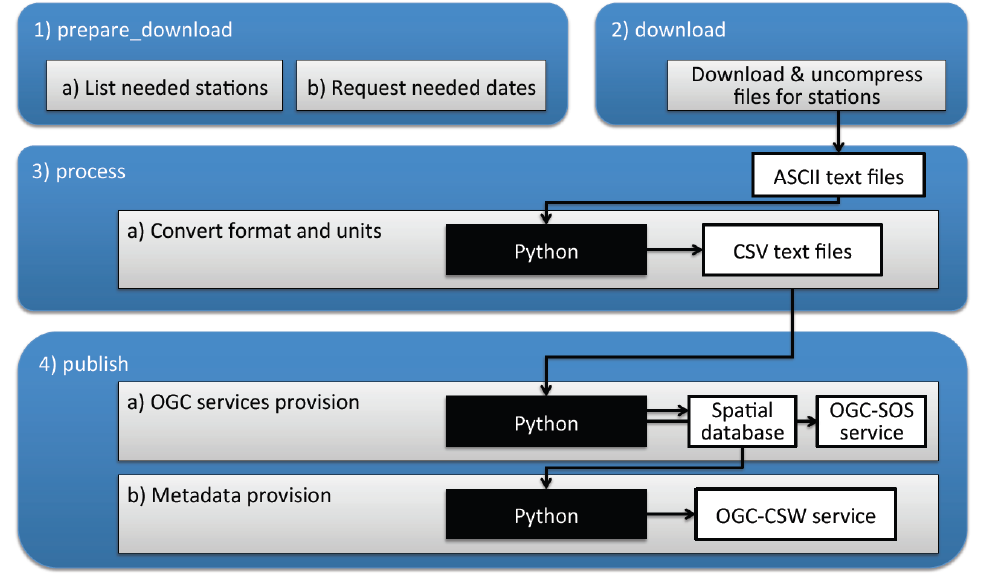
Figure 5. Processing chain for the integration of Global Surface Summary of the Day (GSOD) and Integrated Surface Database (ISD) data.